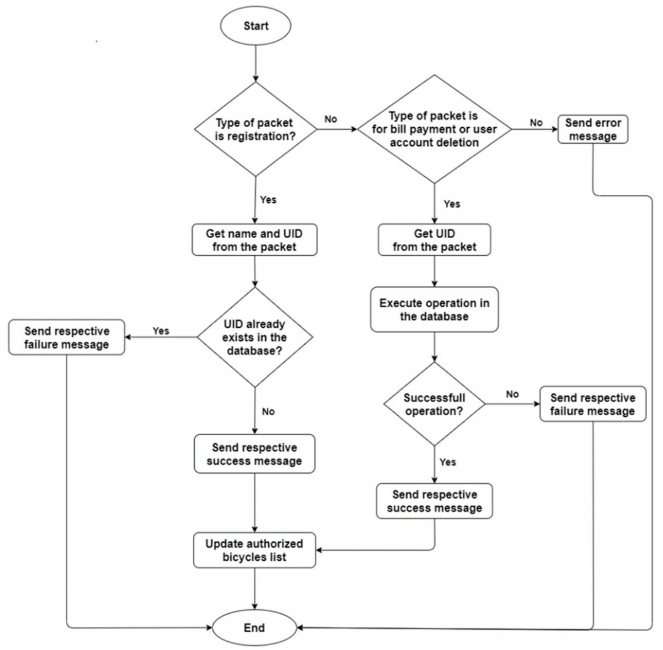
Figure 5. Flowchart of the processing of user account management packets received from the service